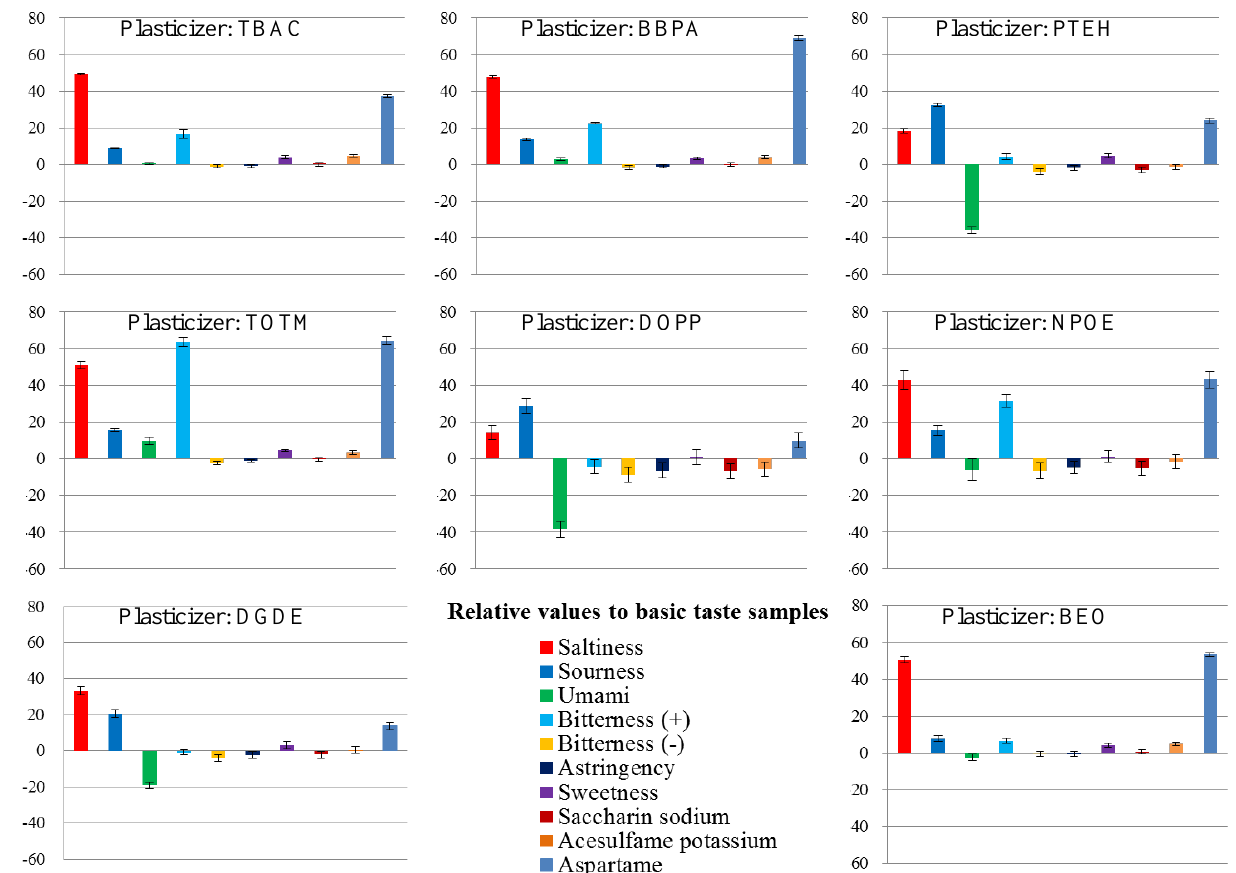
Figure 6. Relative values: basic taste samples were measured using eight kinds of lipid/polymer membrane (parameter of membranes: type of